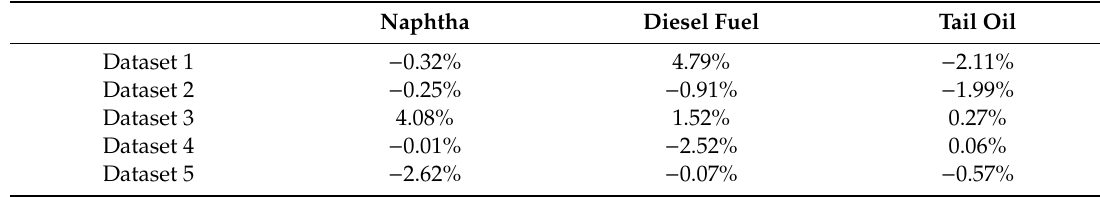
Figure 15. Prediction of the temperature profile of the fractionator.